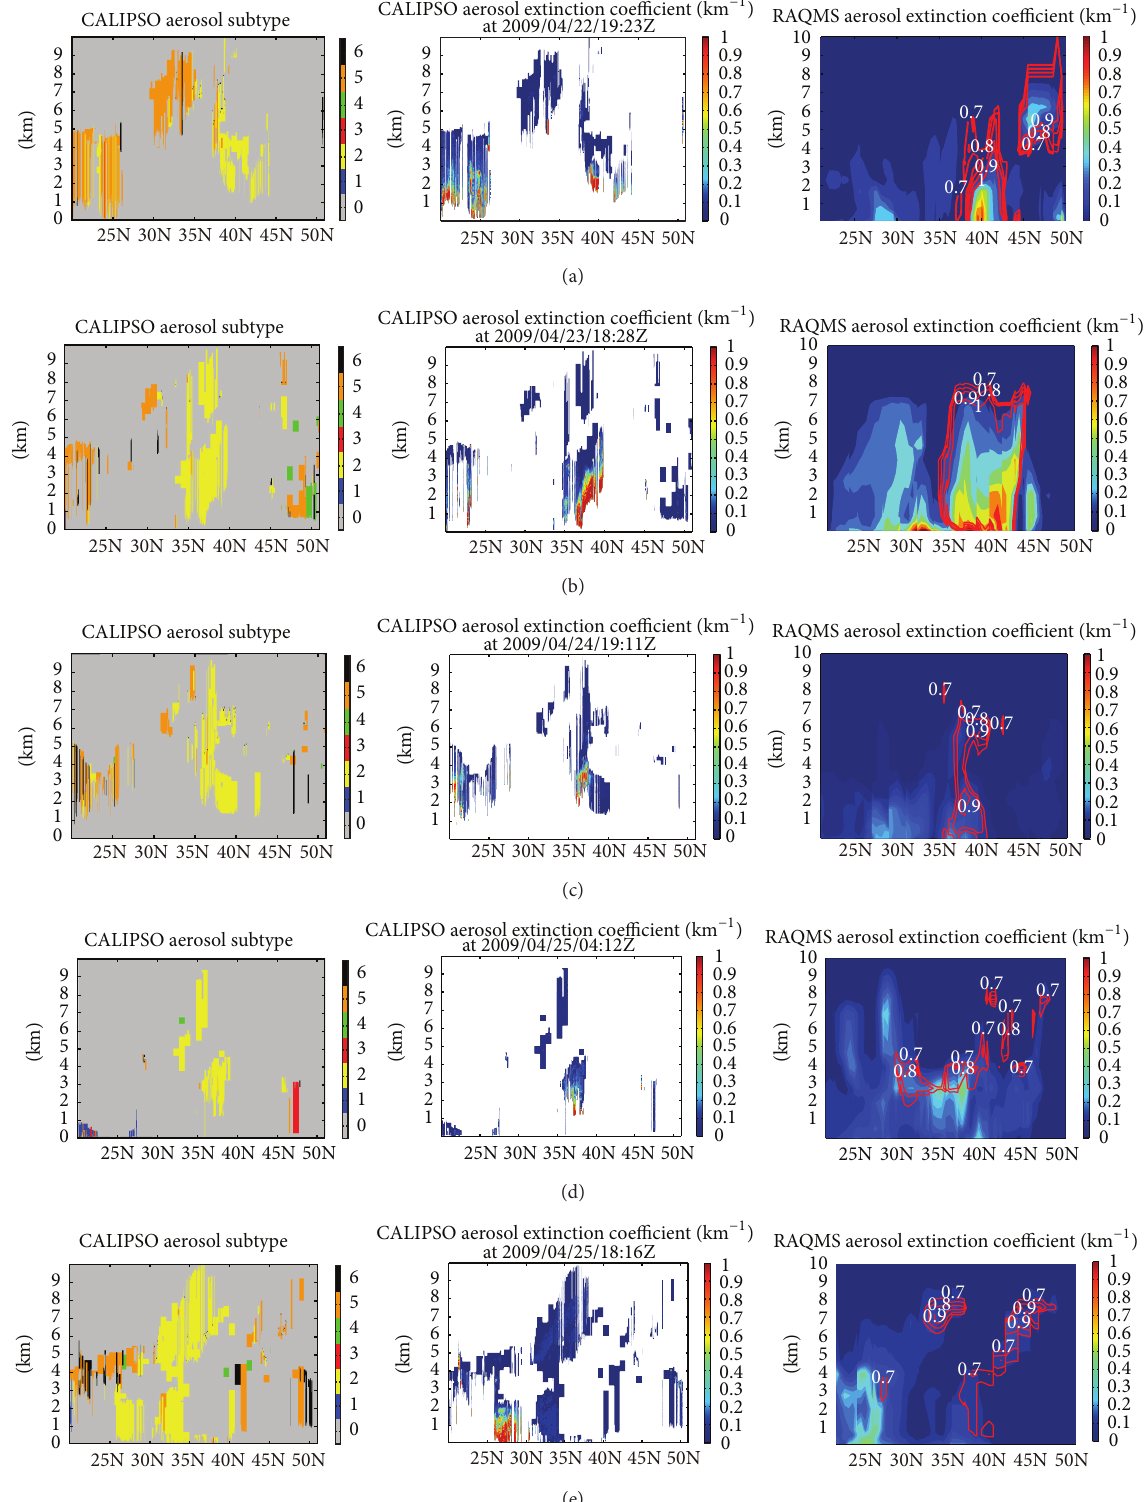
Figure 4: Left column: vertical distributions of aerosol subtype from CALIOP measurements (0 = not applicable, 1 = clean marine, 2 = dust, 3 = polluted continental, 4 = clean continental, 5 = polluted dust, and 6 = smoke); middle column: vertical distributions of aerosol extinction coefficient at 532 nm from CALIOP; right column: simulated aerosol extinction coefficient at 550 nm. Red contours overlaid on simulation results are fractional contributions of dust to total aerosol extinction coefficient. Dates in figure titles are local standard time while orbit times in figure titles are coordinated universal